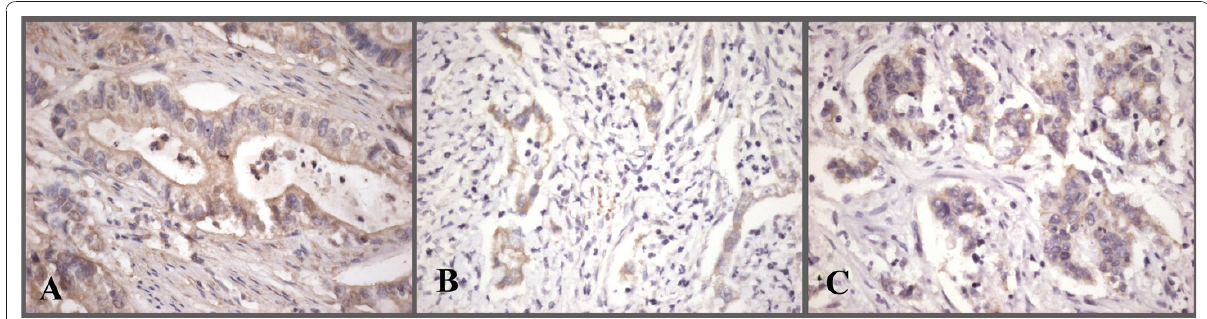
Figure 1 Plakophilin immunostaining in gastric adenocar-cinoma . Focal, moderate cytoplasmic staining with PKP1(A) and PKP3(B); partial membranous staining in addition to focal, moderate cytoplasmic staining with PKP2(C) (×400).